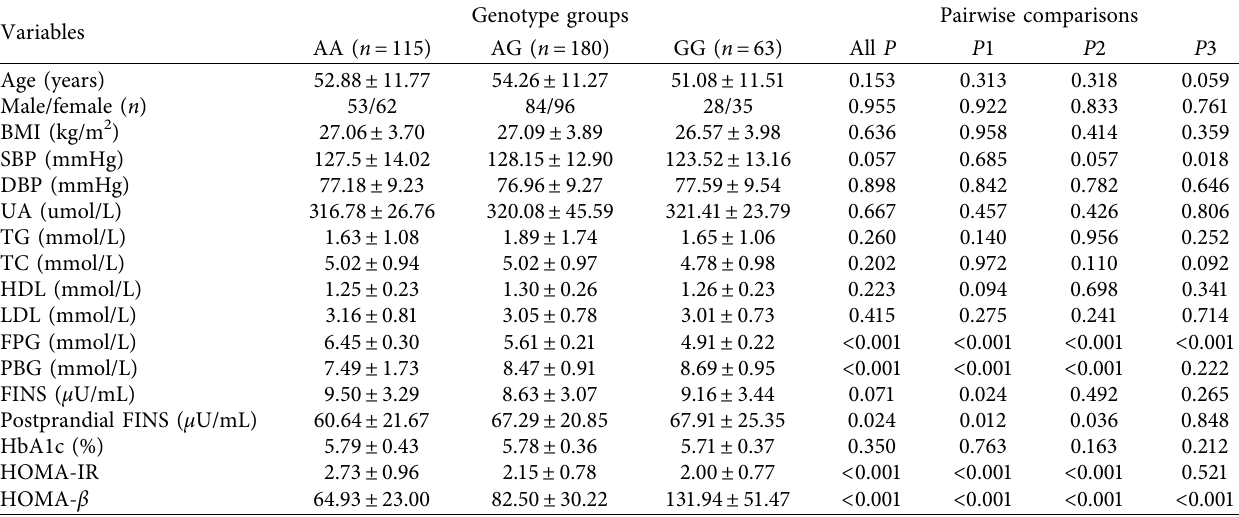
Table 5: Comparisons of biochemical indices of the SLC2A9 A/G (rs1014290) SNP among the diferent genotypes in the pre-DM group. Variables